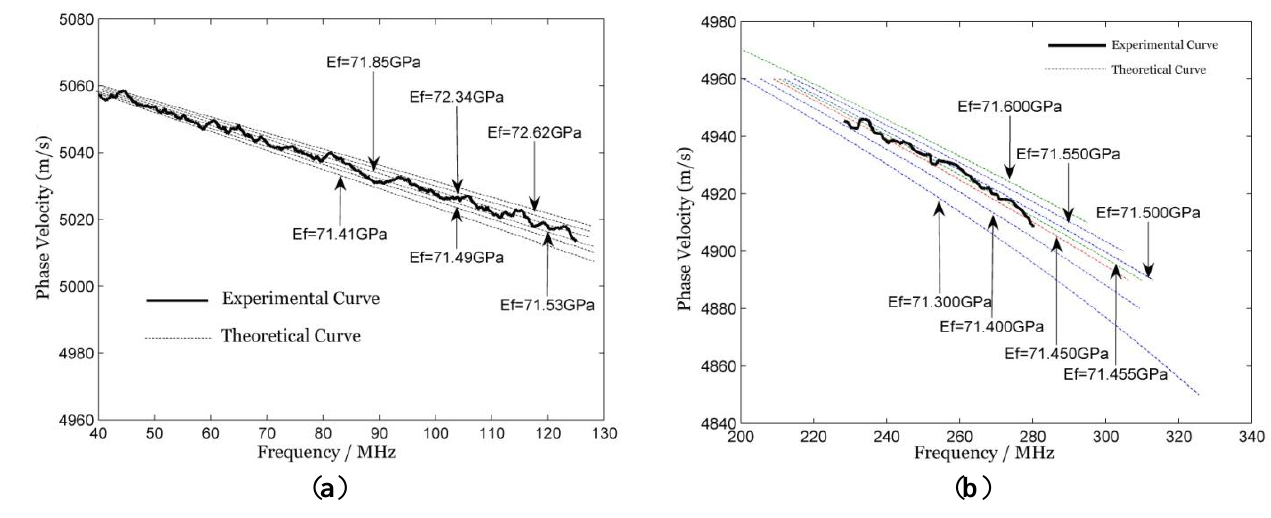
Figure 3. Dispersion curve fitting results of ( a ) piezoelectric LSAW detection technique and ( b ) differential confocal LSAW detection